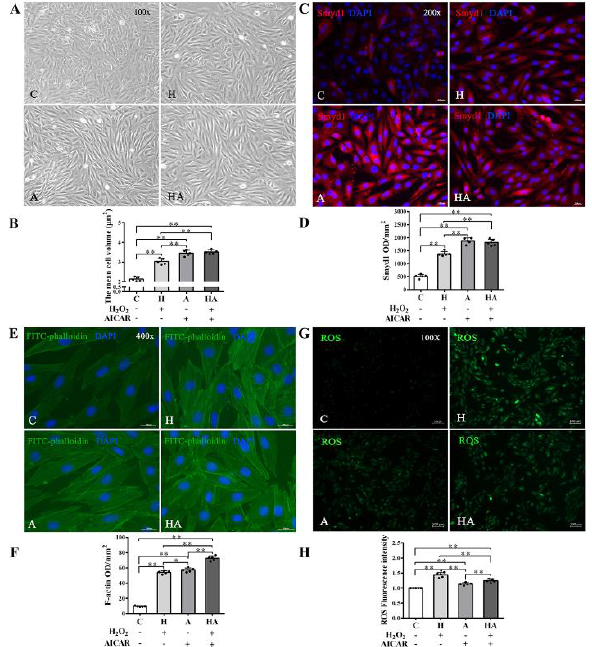
Figure 6. Effects of H 2 O 2 and AMP-activated protein kinase (AMPK) agonist (AICAR) on cell volume, F-actin and reactive oxygen species (ROS) in H9C2 rat cardiomyoblasts in vitro: ( A , B ) cell morphology and volume of H 2 O 2 , AICAR, or H 2 O 2 + AICAR-treated H9C2 rat cardiomyoblasts (scale bar = 100 µ m); ( C , D ) immunofluorescence staining of Smyd1 (red color, graph C ) and integrated optical density (IOD, graph D ). The nuclei of cells were stained by DAPI (blue color), scale bar = 200 µ m; ( E , F ) immunofluorescence staining of FITC-phalloidin (green color, graph E ) and IOD in H9C2 cells (graph F , scale bar = 400 µ m); ( G ) representative images showing ROS generation levels under various treatment conditions; and ( H ) quantified fluorescence intensity. Data are expressed as mean ± Standard Deviation (SD), n = 5 / group. Symbols indicate * p < 0.05 and ** p < 0.01. Abbreviations: C, Untreated control group; H, H 2 O 2 -treated group; A, AICAR-treated group; and HA, H 2 O 2 + AICAR cotreated